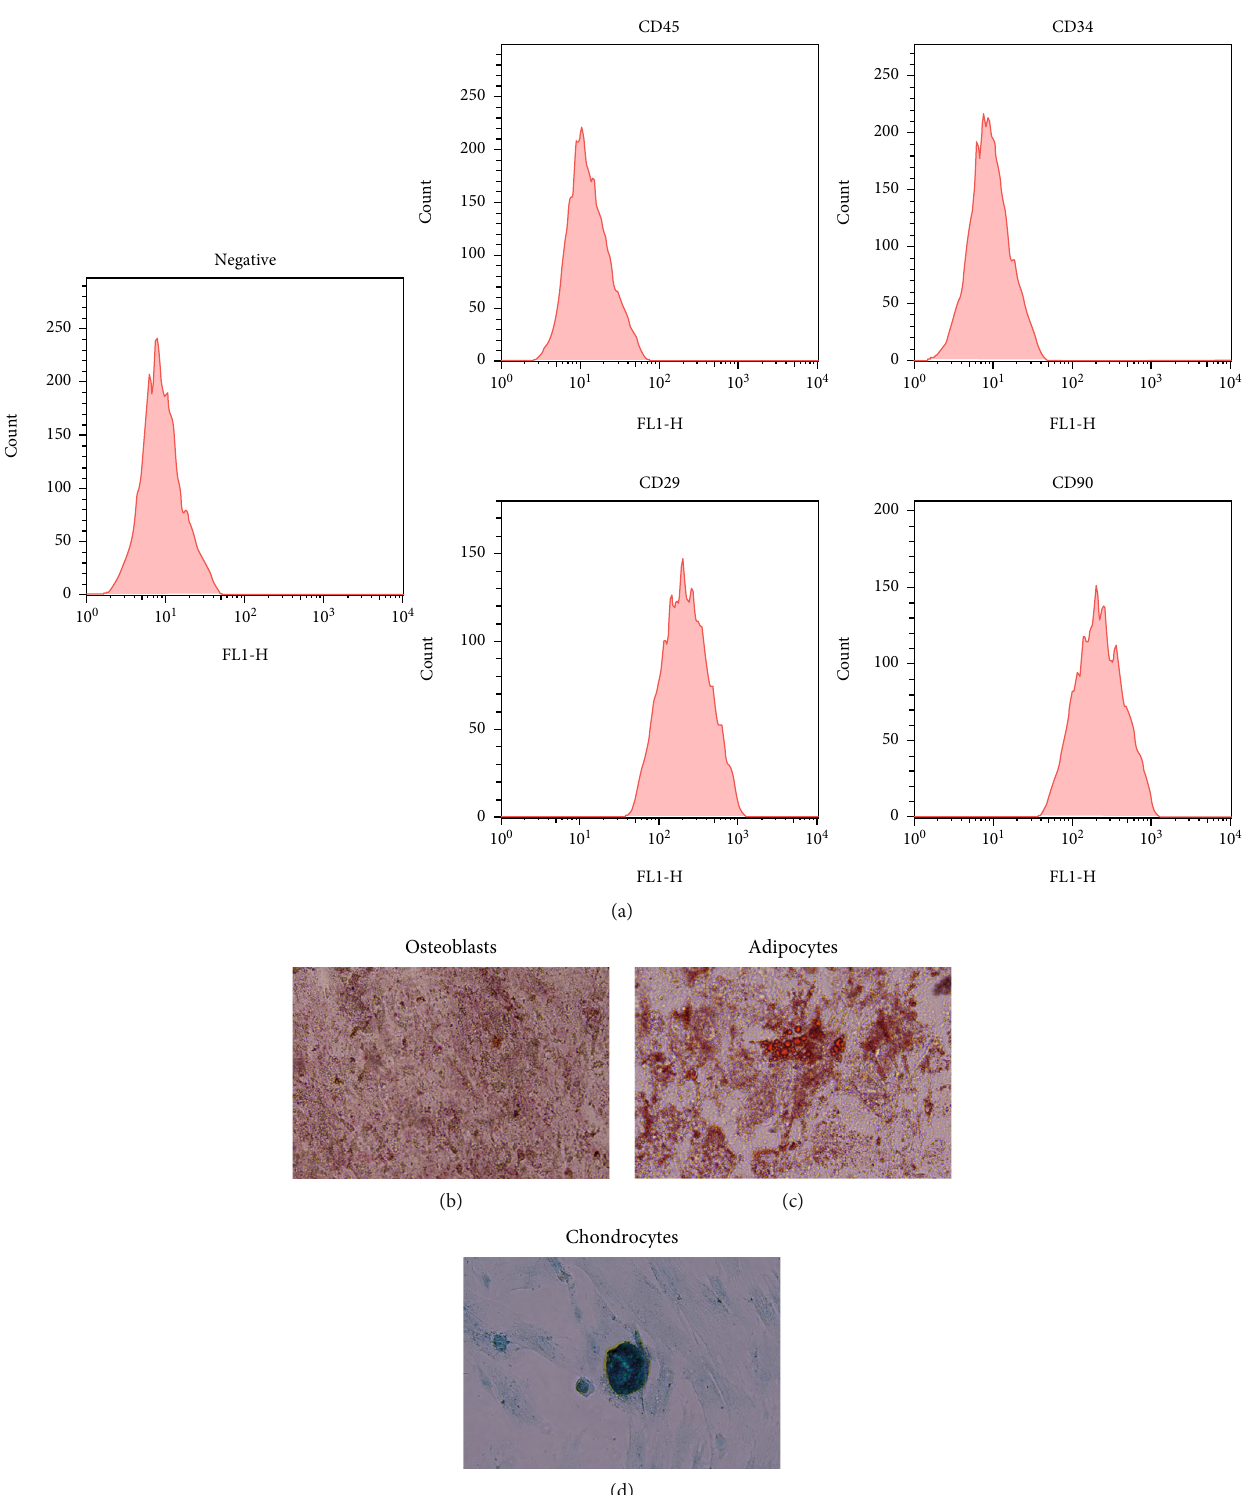
Figure 1: Characterization of ADSCs. (a) The expression of biomarkers (CD29, CD34, CD45, and CD90) was detected by FCM. (b – d) Trilineage di ff erentiation of ADSCs. (b) Osteoblast, base magni fi cation: × 200; (c) adipocytes, base magni fi cation: × 400; (d) chondrocytes, base magni fi cation: ×